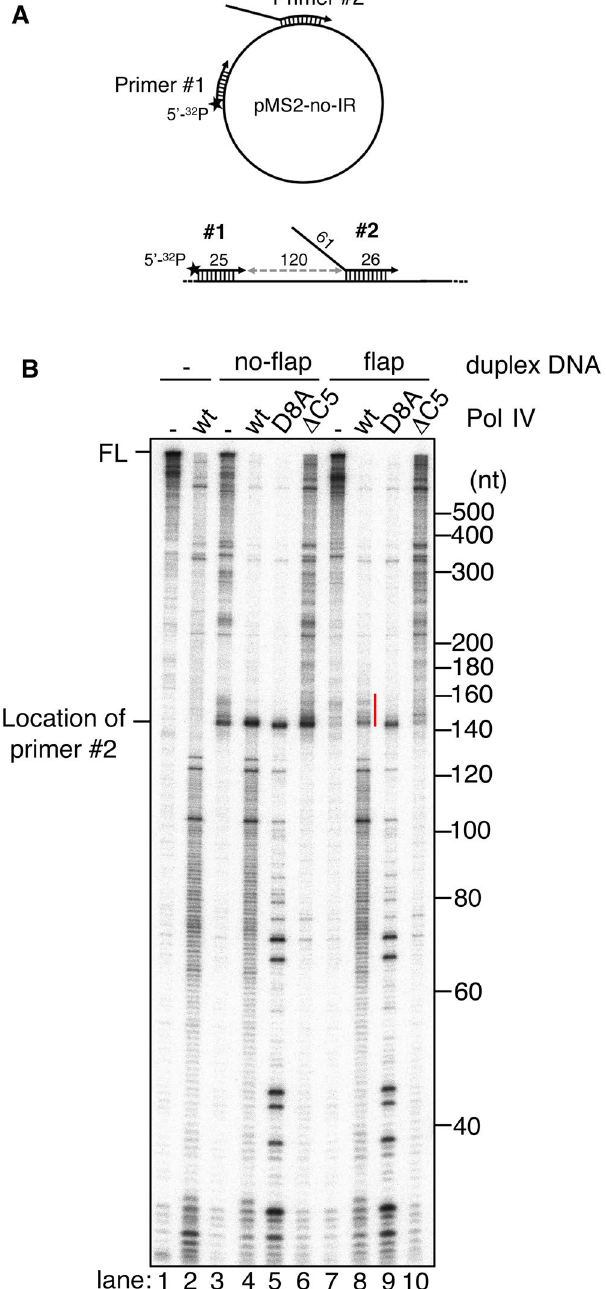
Figure 7. Pol III-Pol IV switching also occurs when Pol III collides with a flapped duplex on template DNA. ( A ) upper : Template DNA used in this assay. A circular ssDNA without an inverted repeat was annealed with 5 ′ - 32 P labeled primer (primer #1) and 61-nt flapped primer (primer #2). The location of a radiolabel is indicated as a black star. lower: Sketch showing the location of two primers. ( B ) The effect of Pol IV on wild-type Pol III HE was tested on the double-primed template. Note that the amount of Pol III * used in this assay was double those used in the other experiments. Template DNA shown in A was used in lanes 7–10. A singly primed template (with primer #1 only, lanes 1 and 2) and no-flap template (with primers #1 and #2 but without 61-nt flap, lanes 3–6) were used as controls. Wild-type or mutant Pol IV (D8A or Δ C5) was added to the reaction together with Pol III at a final concentration of 0 or 100 nM as indicated. Replication products after 10-second elongation reaction were analyzed as in Fig. As expected, the addition of wild-type or Pol IV D8A caused the appearance of pausing bands at the starting position of primer #2 (~145 nt, compare lane 7 with lanes 8 and 9 in Fig. 7B). Remarkably, the further elongation of primer #1 by Pol III HE across this site was largely shut down and neither full-length nor near-full-length prod- ucts were observed when wild-type Pol IV or Pol IV D8A was added (Fig. 7B, lanes 4, 5, 8, and 9). The extension